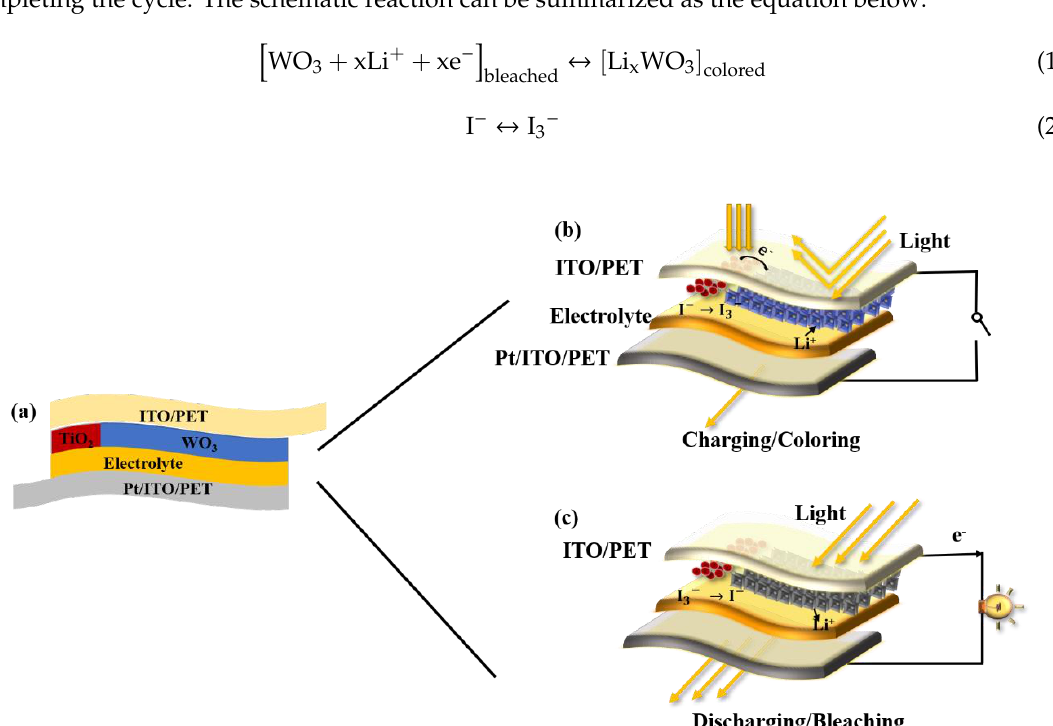
Figure 1. Schematic diagrams of the photoelectrochromic device (PECD); ( a ) photo-charging process of the PECD and ( b ) the discharging process of the PECD ( c ).